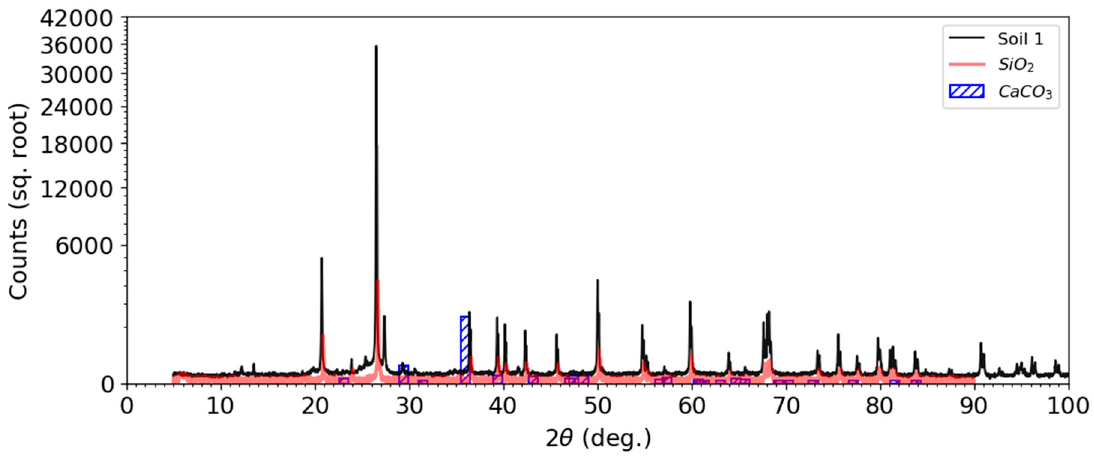
Table 2. Particle size distribution (by volume) properties of soils from the Rotem Plateau.